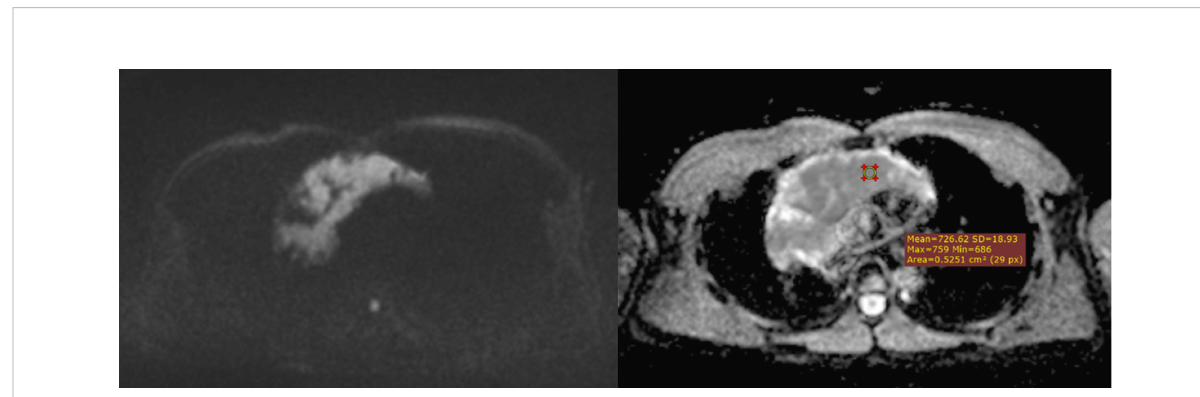
FIGURE 6 A mediastinal seminoma (malignant GCT) presurgically diagnosed as a malignant tumor based on its markedly low ADC value. The mean of 3 ADC values obtained by using the hot-spot-ROI-based approach was 0.7 x 10-3